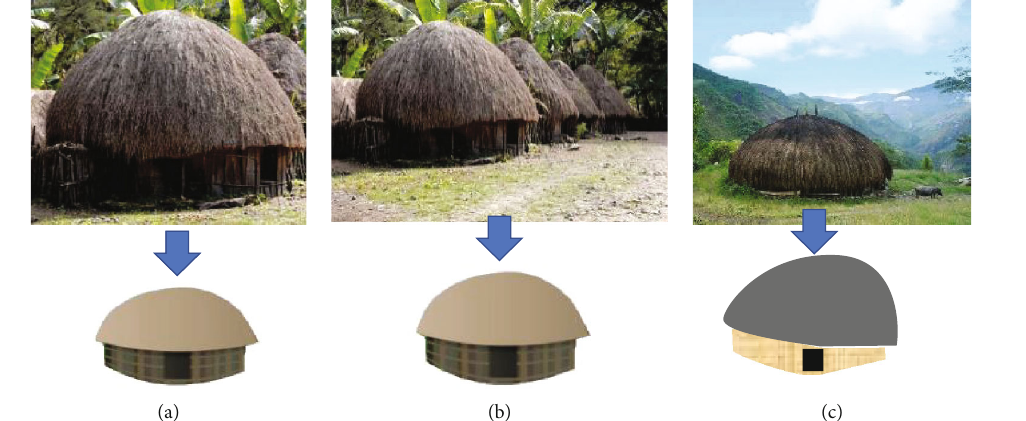
Figure 57: Hanoi House, example of Building Number ̂ 7